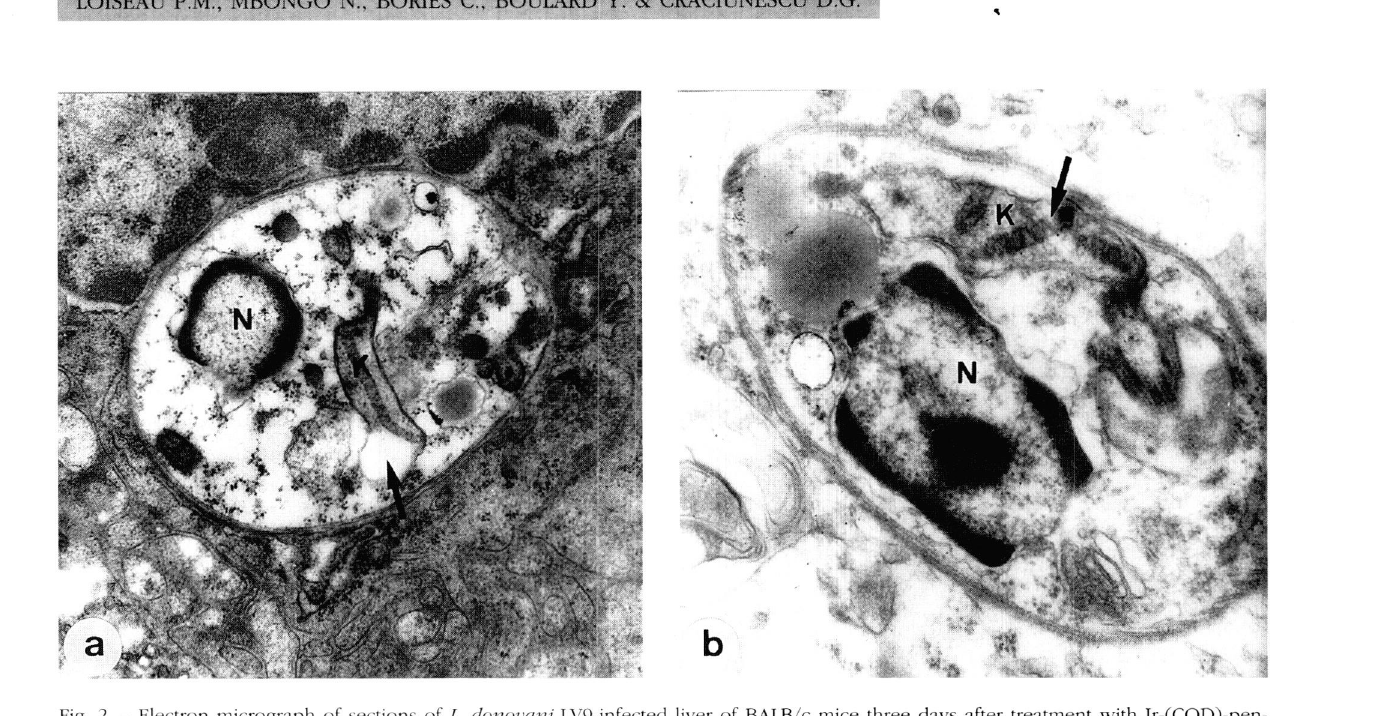
Fig. 2. - Electron micrograph of sections of L. donovani LV9-infected liver of BALB/c mice three days after treatment with Ir-(COD)-pen- tamidine tetraphenylborate administered intraperitoneally at 50 mg pentamidine equivalent /kg/day x 5. Within these treated parasites, the most stricking features are: a) a clear cytoplasm due to a depleted ribosomal material, a nuclear membrane convoluted and a kinetoplast presenting major alterations: swollen mitochondrion, low electron density of probably depolymerized kDNA (x 15,000). b) fragmentation of the kDNA in a deflated mitochondrion. In addition, the alterations already observed in Figure 2a can also be noted here (x 20.000).